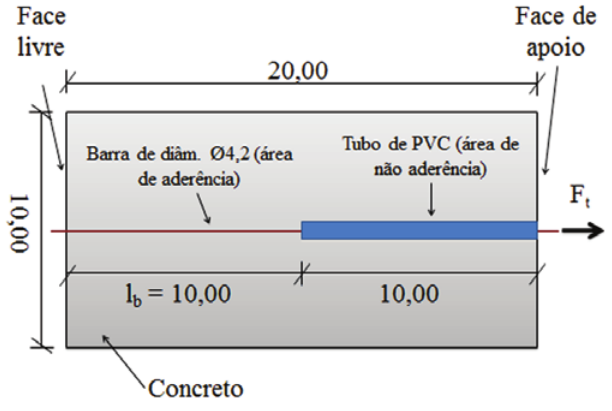
Nota: l : comprimento de ancoragem longitudinal; b F : força de arrancamento. Cotas em t Figura 1 CP tipo "Barra" (corte longitudinal)